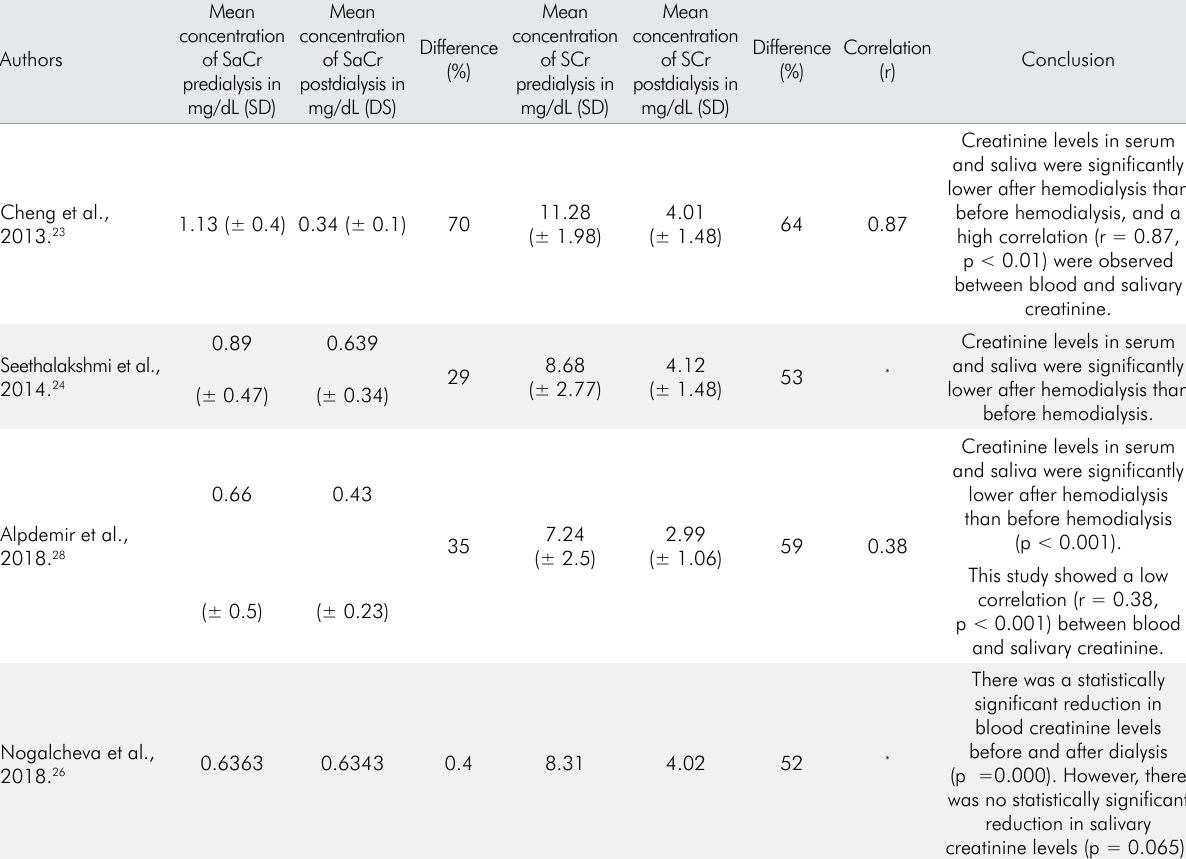
Table 4. Main results of the eligible studies investigating creatinine levels.